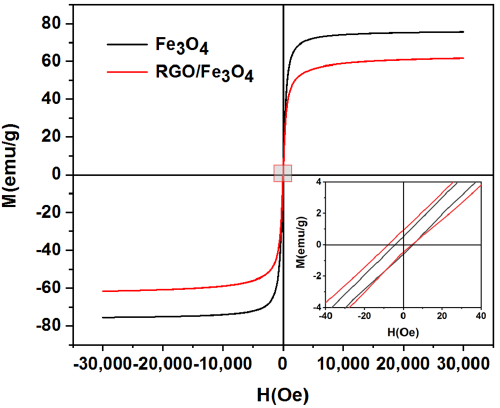
Figure 6. Room − temperature magnetic hysteresis loops of different samples.